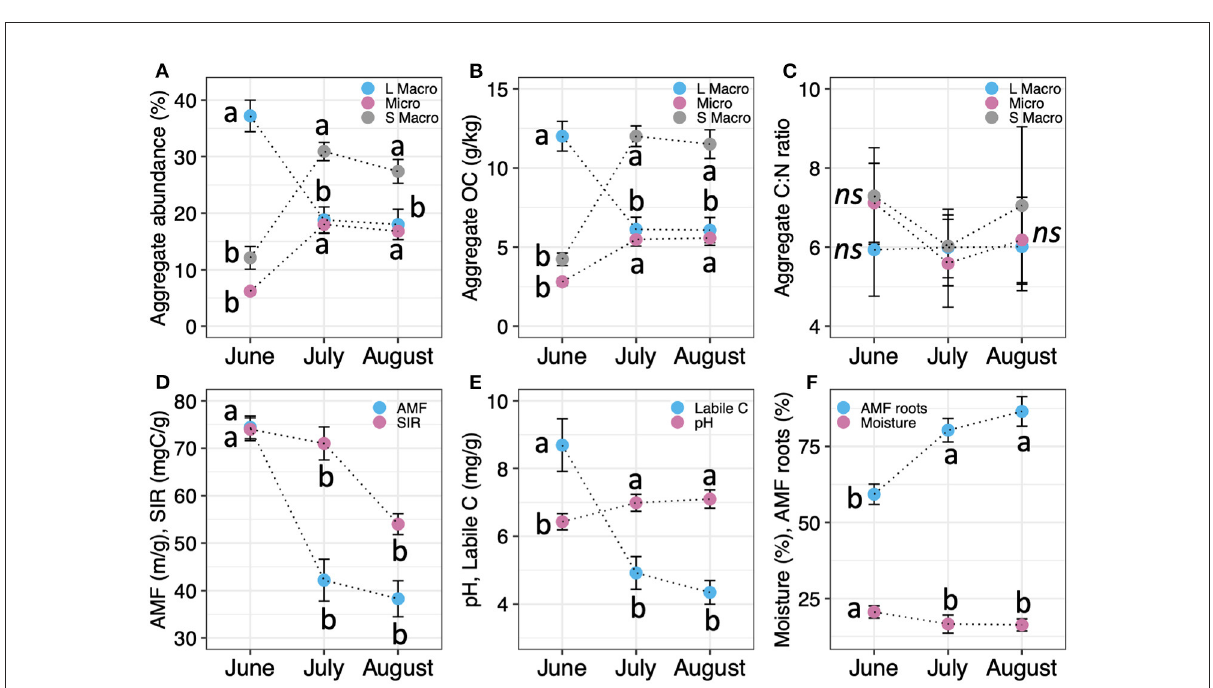
FIGURE5 Temporal variation in (A) WSA abundance, (B) aggregate OC, (C) aggregate C:N; (D) AMF hyphal length and SIR, (E) pH and labile SOC levels; and (F) moisture and AMF root colonization after site conversion. Vertical bars indicate the standard error of the mean. For each soil factor, points with the same letter do not differ significantly at p <